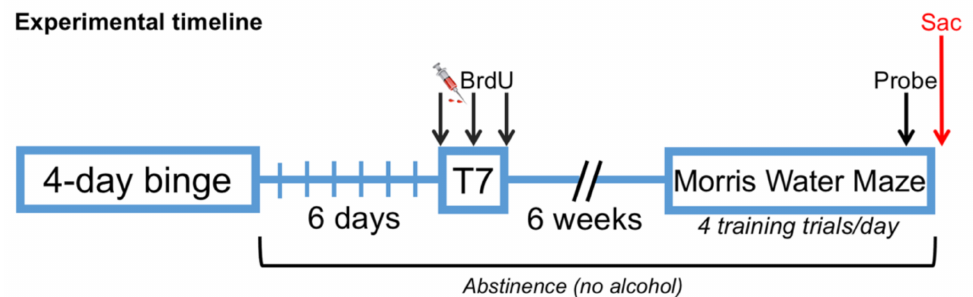
Figure 1. Experimental timeline: Seven days after the final dose of alcohol, all rats were administered 3 i.p. injections of bromodeoxyuridine (BrdU) every 8 h. The rats then underwent 6 additional weeks of undisturbed abstinence in the home cage to allow for maturation of the proliferating cells. Starting on day 49 of abstinence, all animals were trained to perform the Morris Water Maze (MWM) over the course of 4 days. One hour after the final training session on day 52 (the fourth day of training), the platform was removed and all rats were tested in a probe trial. All animals were sacrificed (SAC) 90 min after their final MWM training trial (not including the probe